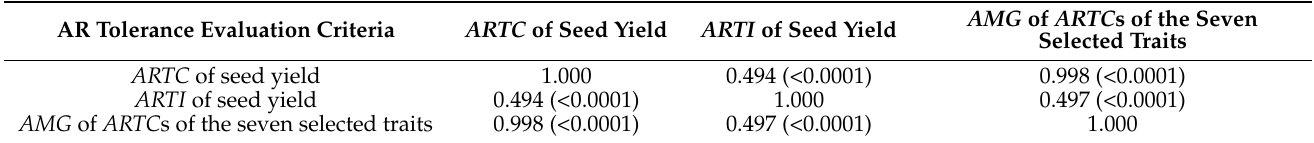
Table 6. Spearman rank correlation coefficients among the three AR tolerance evaluation criteria. AR Tolerance Evaluation